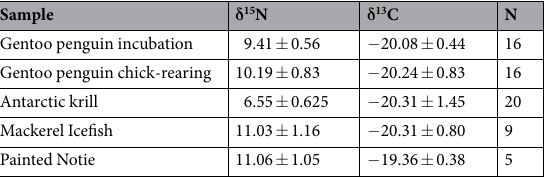
Table 1. Stable isotope ratio in plasma of gentoo penguins and in homogenised tissues of their prey (means ± 1 SD).